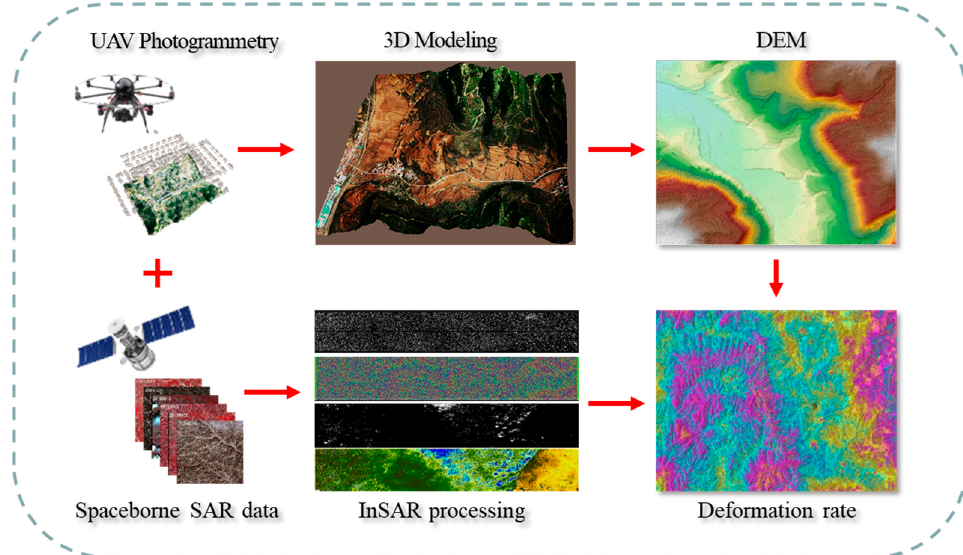
Figure 2. Flow chart of CCUS deformation monitoring.